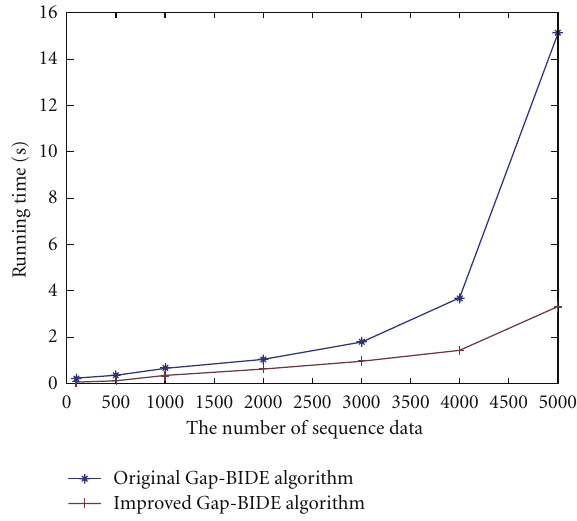
Figure 2: Comparing with original Gap-BIDE.